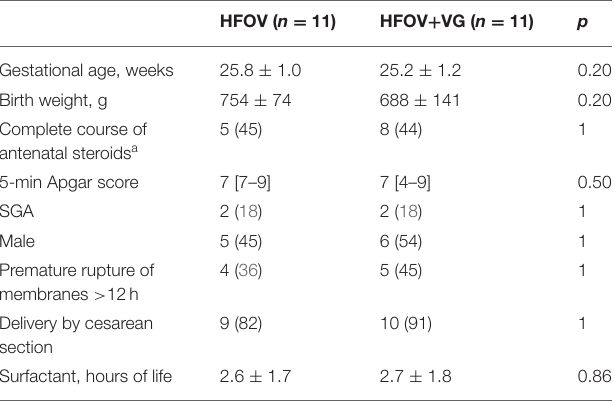
TABLE 1 | Patient and maternal demographics and neonatal characteristics at birth.